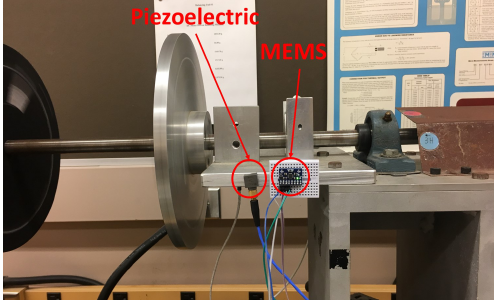
Figure 3. Piezoelectric and MEMS sensors mounted on motor testbed.